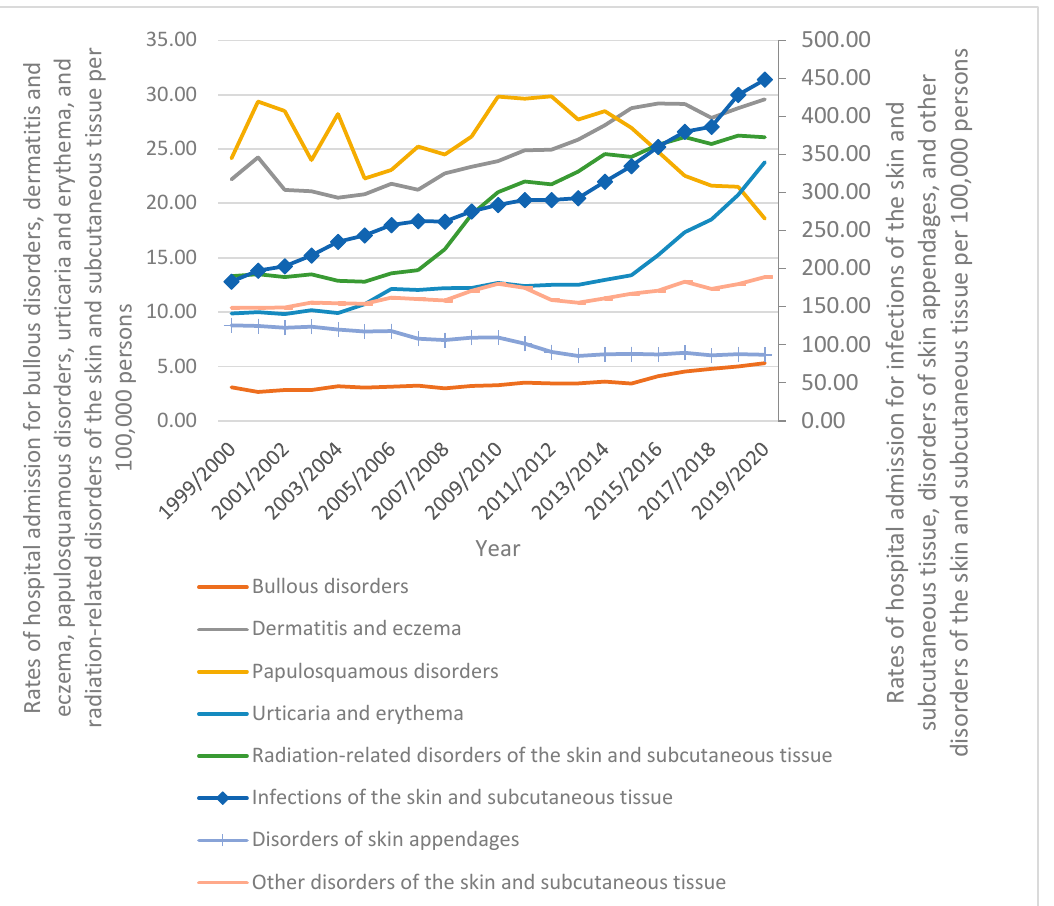
Figure 1. Rates of hospital admission stratified by type between 1999 and 2020. In terms of age differences for hospital admission, those between the ages of 15 and 59 years made up 50.5% of the total, followed by those 75 years and over with 21.7%, those between the ages of 60 and 74 years with 20.0%, and those less than 15 years with 7.9%. From 276.25 (95%CI 272.98–279.52) in 1999 to 290.89 (95%CI 287.67–294.11) in 2020, hospital admission rates for patients under the age of 15 years increased by 5.3%. From 487.47 (95%CI 485.04–489.91) in 1999 to 652.68 (95%CI 649.99–655.37) in 2020, the rate of hospital admission for patients aged 15 to 59 years increased by 33.9%. From 720.31 (95%CI 714.01–726.60) in 1999 to 1147.74 (95%CI 1140.91–1154.56) in 2020, hospital admission rates for patients aged 60 to 74 years increased by 59.3%. Patients 75 years old and over experienced a 1.10-fold rise in hospital admission rates, going from 1177.84 (95%CI 1167.15–1188.53) in 1999 to 2475.15 (95%CI 2461.76–2488.54) in 2020 per 100,000 people (Figure 2). During the study period, there were 7,608,889 hospital admission episodes reported in England and Wales. In total, 3,887,209 hospital admission episodes, or a mean of 185,105 admissions per year, were of males, who made up 51.1% of the total number of hospital admissions. In 2020, the hospital admission rate for males increased by 60.2%, from 540.16 (95% CI 537.32–543.01) in 1999 to 865.10 (95% CI 861.76–868.44) per 100,000 people in 2020. From 520.75 (95% CI 518.02–523.48) in 1999 to 791.03 (95% CI 787.86–794.19) in 2020, the hospital admission rate for females grew by 51.9% (Figure